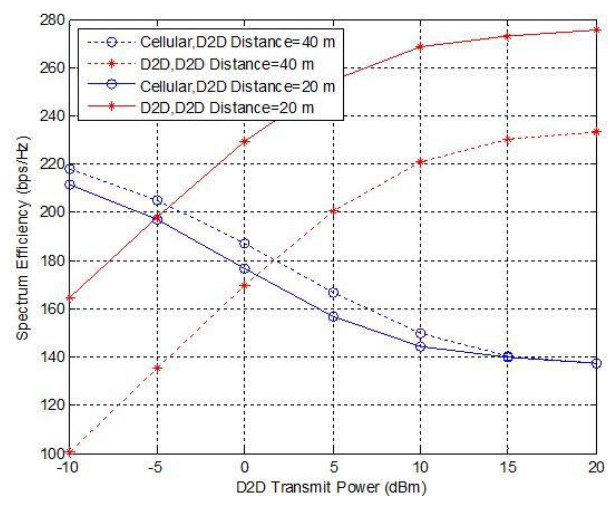
Figure 2. The spectrum efficiencies of the D2D pairs and CUs versus the transmit power budget.